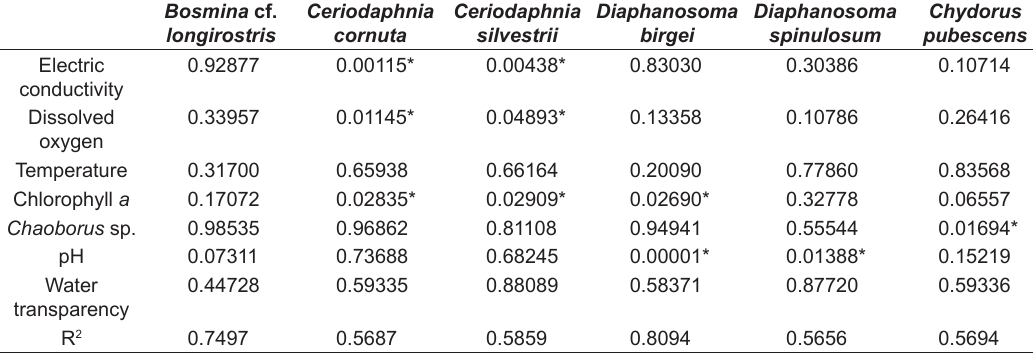
Table 2. Results from multiple regression analysis among the main migratory species of Cladocera and the physical and chemical parameters of water during a single nictemeral cycle, at a sampling station of Furnas reservoir, Minas Gerais State,